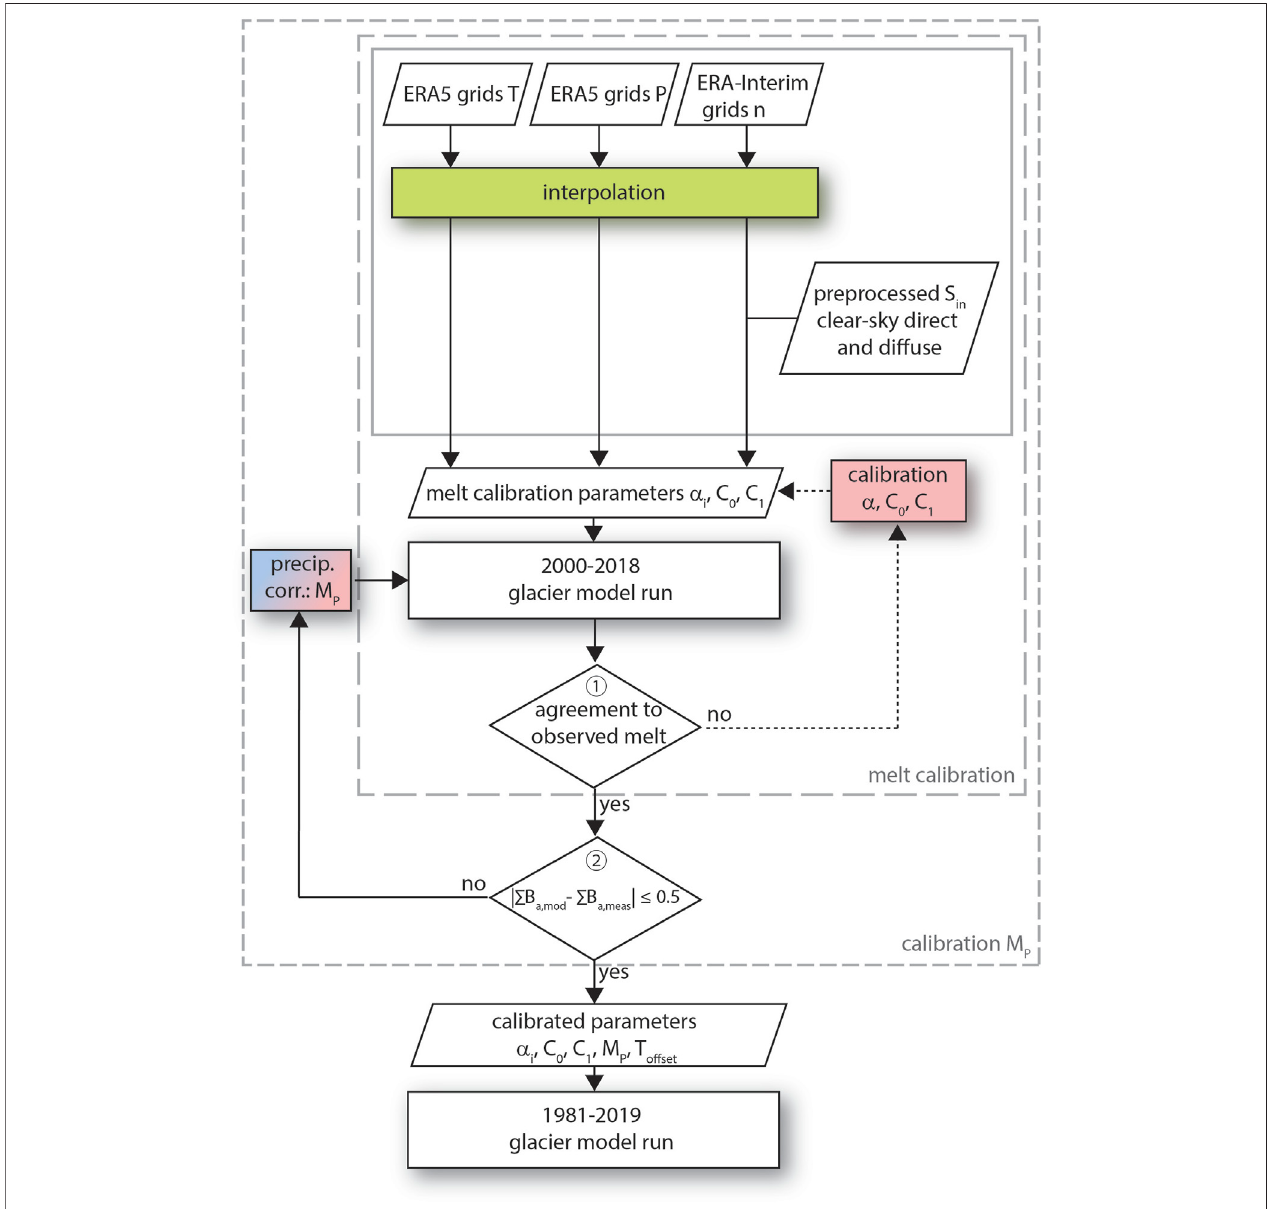
FIGURE 2 | Flowchart of the modeling process. Steps related to the simple downscaling-approach are highlighted in light-green and mass balance model calibration in light-red. Arrows with dotted lines denote manual steps. Note that the conditions 1 – 2 are fi rst tested for (cid:3) B a ,mod (cid:2) (cid:3) B a , meas intermediate , where B a is the annual mass balance. Calibrated values α , C 0 and C 1 are then used in the calibration phase to (cid:3) B a ,mod (cid:2) (cid:3) B a , meas maximum and (cid:3) B a min mod minimum where the conditional steps (1) and (2) are omitted.